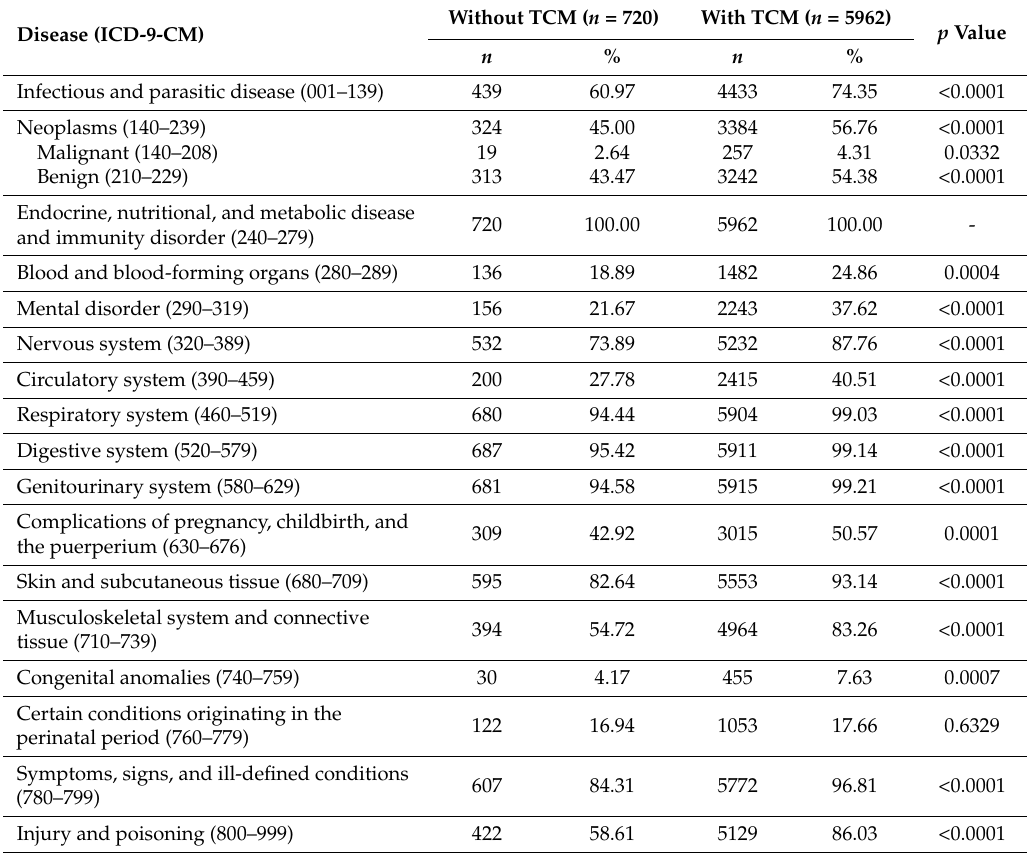
Table 4. The distribution of TCM and non-TCM users by major disease categories/diagnosis in patients with